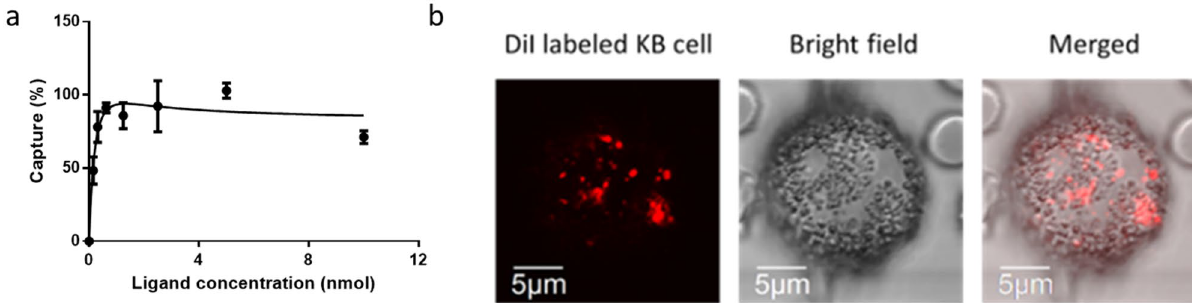
Figure 4. ( a ) Effect of folate-Pro6-PEG12-biotin concentration on the efficiency of capture of spiked FR + KB cells from fresh whole blood obtained from healthy donors. Dynabeads were incubated for 1 h with different concentrations of folate-Pro 6 -PEG 12 -biotin and then washed 3 × in PBS before adding to fresh whole blood spiked with 100 KB cells/mL blood. CTC capture efficiency was then quantitated by counting under microscope ( b ) Fluorescent and white light microscopy image of whole blood smear after incubation with labeled beads showing bead-coated cancer cell surrounded by healthy blood cells. DiI corresponds to 1,1’-Dioctadecyl- 3,3,3’,3’-Tetramethylindocarbocyanine. Error bars represent standard deviation (n =